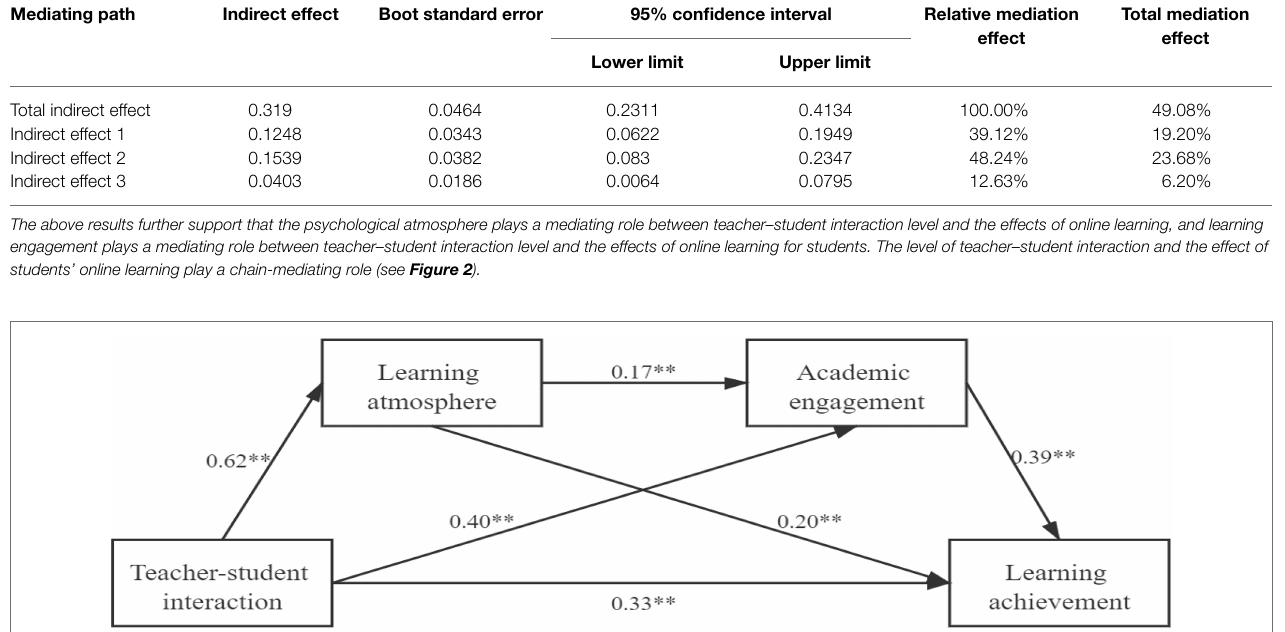
TABLE 4 | Bootstrap results for the mediation effect. Mediating